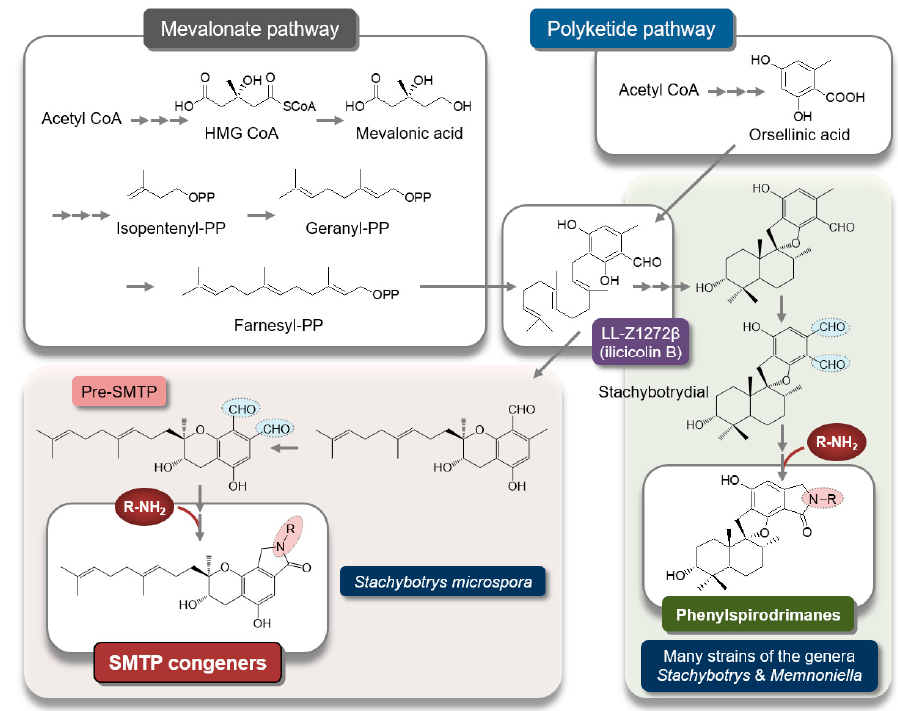
Figure 2. Putative pathway for SMTP biosynthesis. The synthetic pathway for SMTP-type and phenylspirodrimane-type triprenyl phenols may diverge, through differential cyclization mechanisms, from LL-Z1272 β (ilicicolin B), a key intermediate synthesized from farnesyl diphosphate and orsellinic acid [63]. Pre-SMTP forms various SMTPs via a nonenzymatic reaction with an amine. Stachybotrydial [66] may yield a wide variety of phenylspirodrimanes via a similar mechanism, because aromatic o -dialdehydes (shaded in light blue) are highly reactive with an amine [67,68]. The precursor amine feeding method can be applied to selectively synthesize a phenylspirodrimane of interest [69] using Stachybotrys sp. F462, which forms stachybotramide, a phenylspirodrimane-type triprenyl phenol